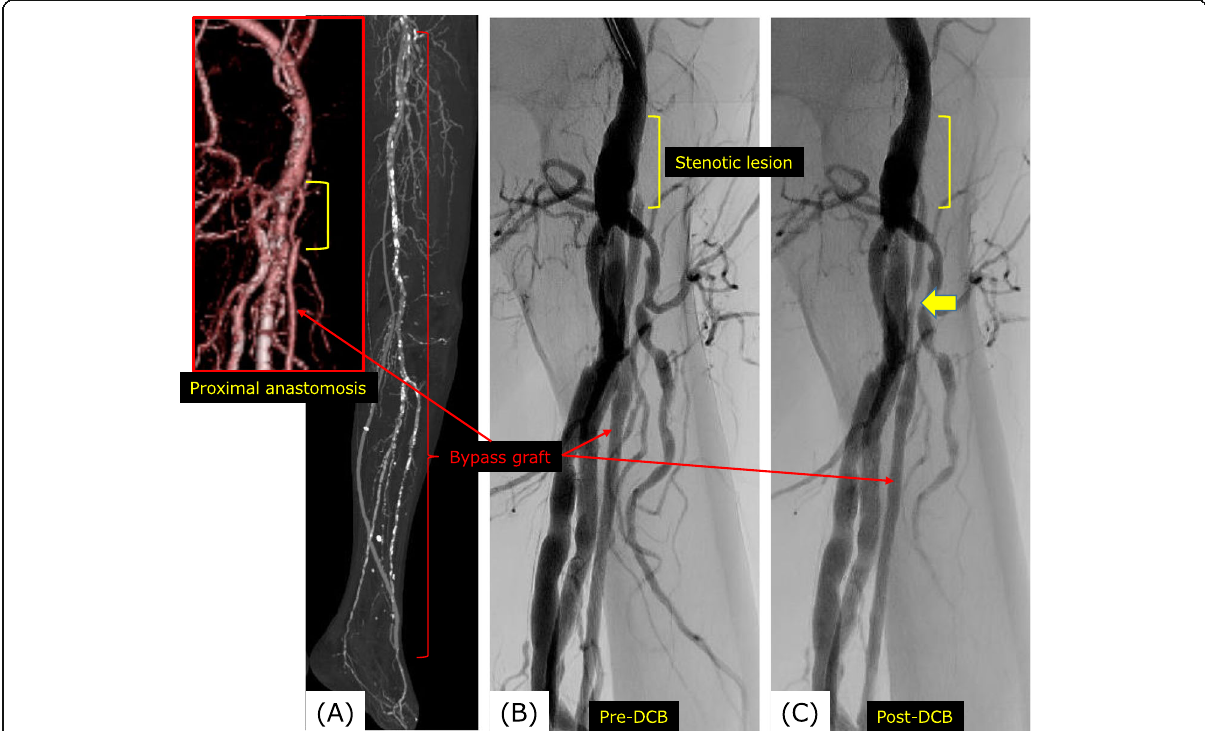
Fig. 1 a Computed tomography angiography after distal bypass surgery. The reversed saphenous vein bypass is shown with a red bracket. The proximal anastomotic site was focused in another window. b Intra-arterial digital angiography before percutaneous transluminal arterioplasty with drug-coated balloons (DCBs). The stenosed area of the reversed saphenous vein graft is shown with a yellow bracket and the bypass graft is shown with a red arrow. c Intra-arterial digital angiography after PTA with DCB. The stenotic lesion was successfully dilated using a DCB. Another re-stenotic lesion was shown below without PSV increase, for which we dilated with